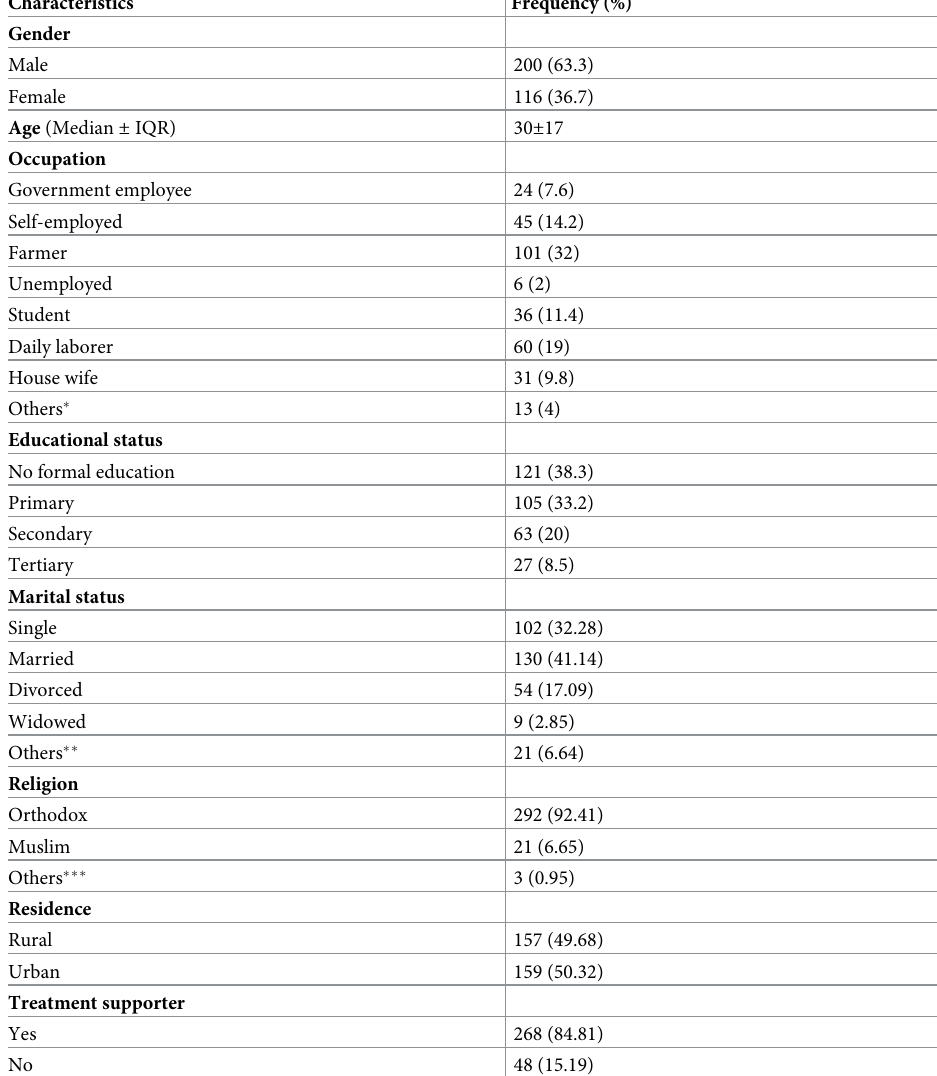
Table 1. Socio-demographic characteristics of MDR-TB patients in North West Ethiopia, 2010 to 2020 (N = 316).